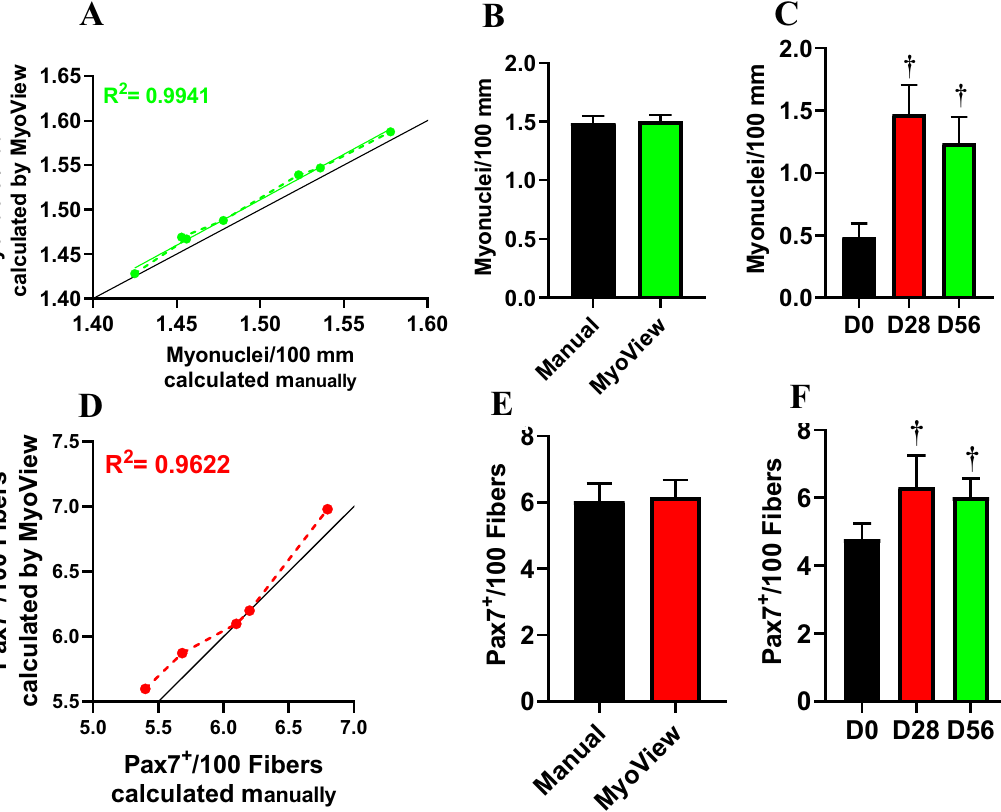
Figure 9. MyoView is comparable with manual quantification for analyzing myonuclei and satellite cell numbers. ( A ) Myonuclear numbers determined by MyoView are on the y-axis and numbers determined manually are on the x-axis. ( B ) Myonuclear numbers were not different when determined with MyoView or by manual quantification ( P > 0.98). ( C ) The effect of HIIT on myonuclear numbers (measured with MyoView). ( D ) Satellite cell numbers determined by MyoView are on the y-axis and numbers determined manually are on the x-axis. ( E ) Satellite cell numbers were not different when determined with MyoView or by manual quantification ( P > 0.95). ( F ) The effect of HIIT on satellite cell numbers (measured with MyoView). † P < 0.05 as compared with D0. Bar = 25